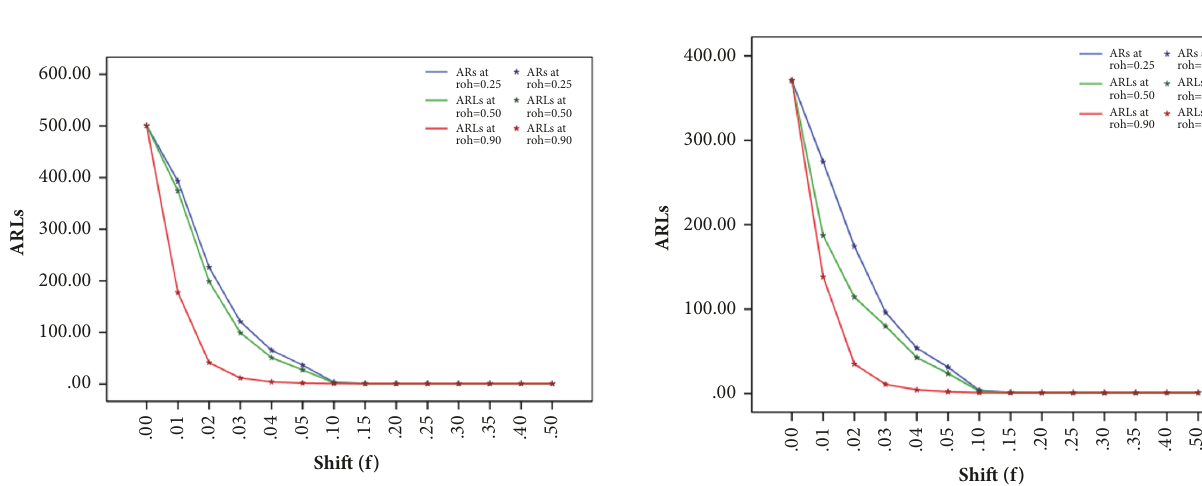
Figure 10: ARLs for proposed repetitive EWMA-RSS control chart using Khan et al. [8] ratio estimator, when 𝑟 𝑜 = 370 at 𝜆 = 0.1.